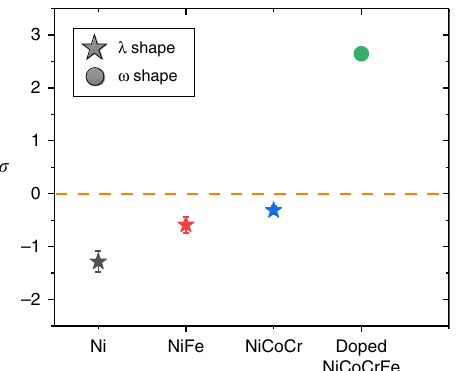
Fig. 4 Logarithmic ratio of Ni 2 + /Ni 1 + between the matrix and void shell for different alloys studied. Error bars for each data points are from standard deviation of measured ratios from multiple voids in each